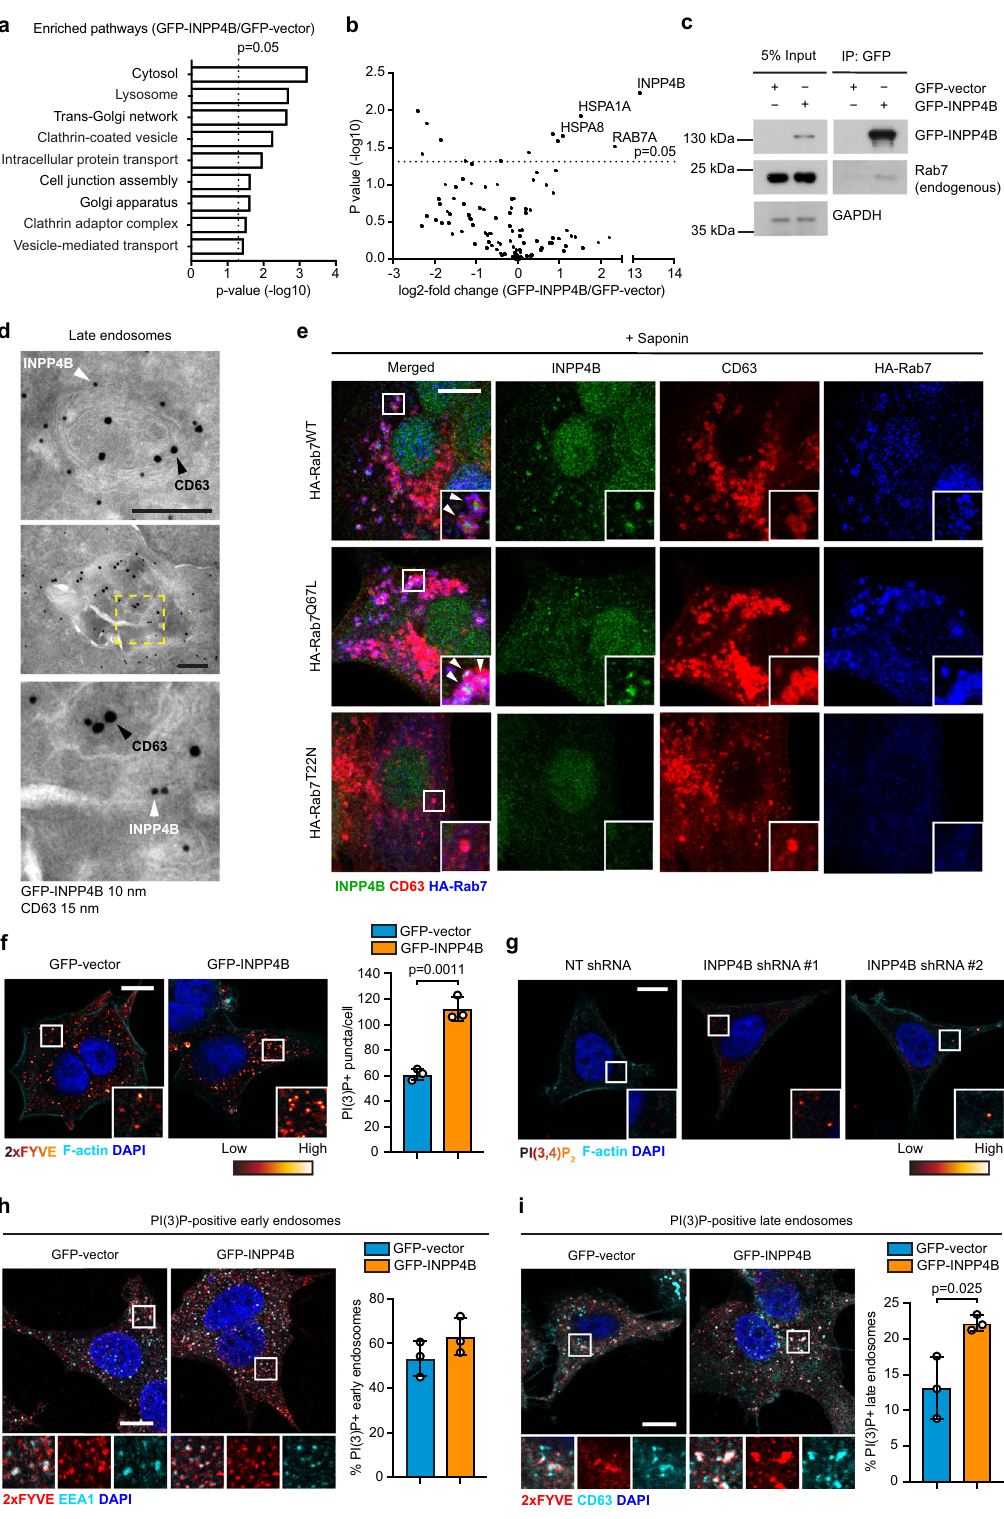
INPP4B promotes PI3K α -dependent late endosome formation . Endomembrane PI(3)P signaling is essential for binding and localizing FYVE or phox homology (PX) domain-containing proteins to endosomal membranes to regulate numerous pro- cesses including early endosome fusion, early-to-late endosome maturation, and cargo sorting 30 . Examination of the endolyso- somal compartments of MCF-7 cells showed that